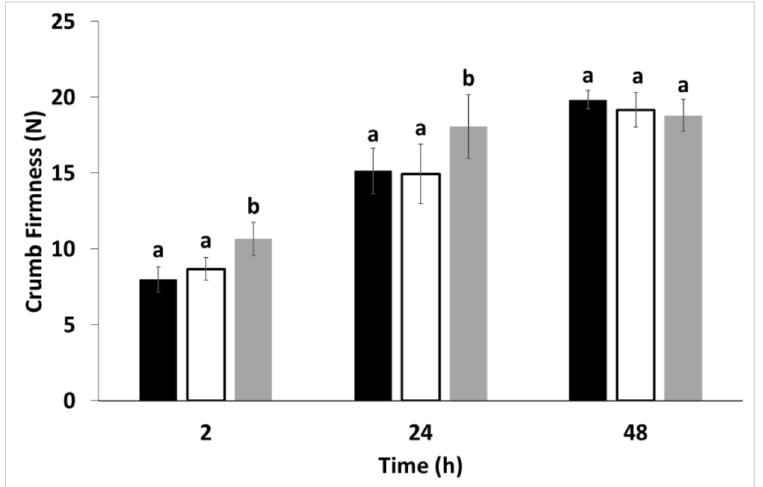
Figure 6. Crumb firmness of bread prepared from wheat flour alone (black), and with increasing replacement level of cricket powder (10%: white; 20%: grey), after 2, 24 and 48 h of baking. Data are expressed as mean ± standard deviation. Different letters at the same storage time indicate significant differences (one-way ANOVA, Tukey’s HSD test, p ≤ 0.05).